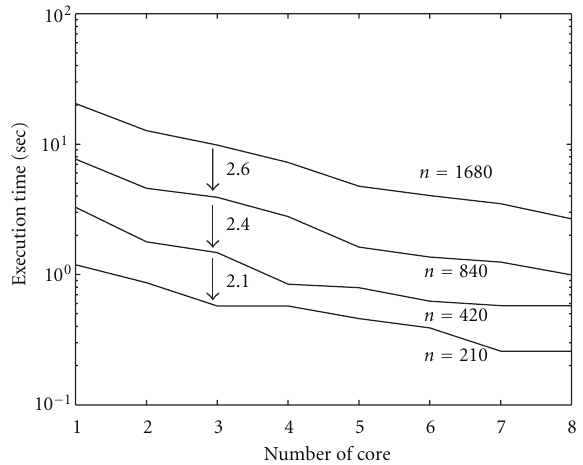
Figure 29: Scalability of parallel Algorithm I, as N is fixed and p varies, and N = 210,420,840,1680. Each line refers to the execution time of the algorithm at a fixed value of N . Δ τ I = 0 . 4.